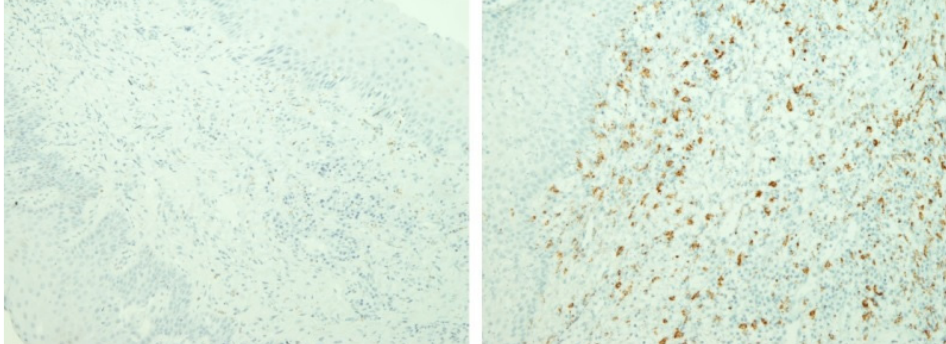
Figure 3. Example samples of immuno-staining for macrophages in sensitised and non-sensitised patients. (Expression of CD68 molecule (macrophages) is in brown. On the left gingival tissue of sensitised patient, while on the right gingival tissue of non-sensitised patient).